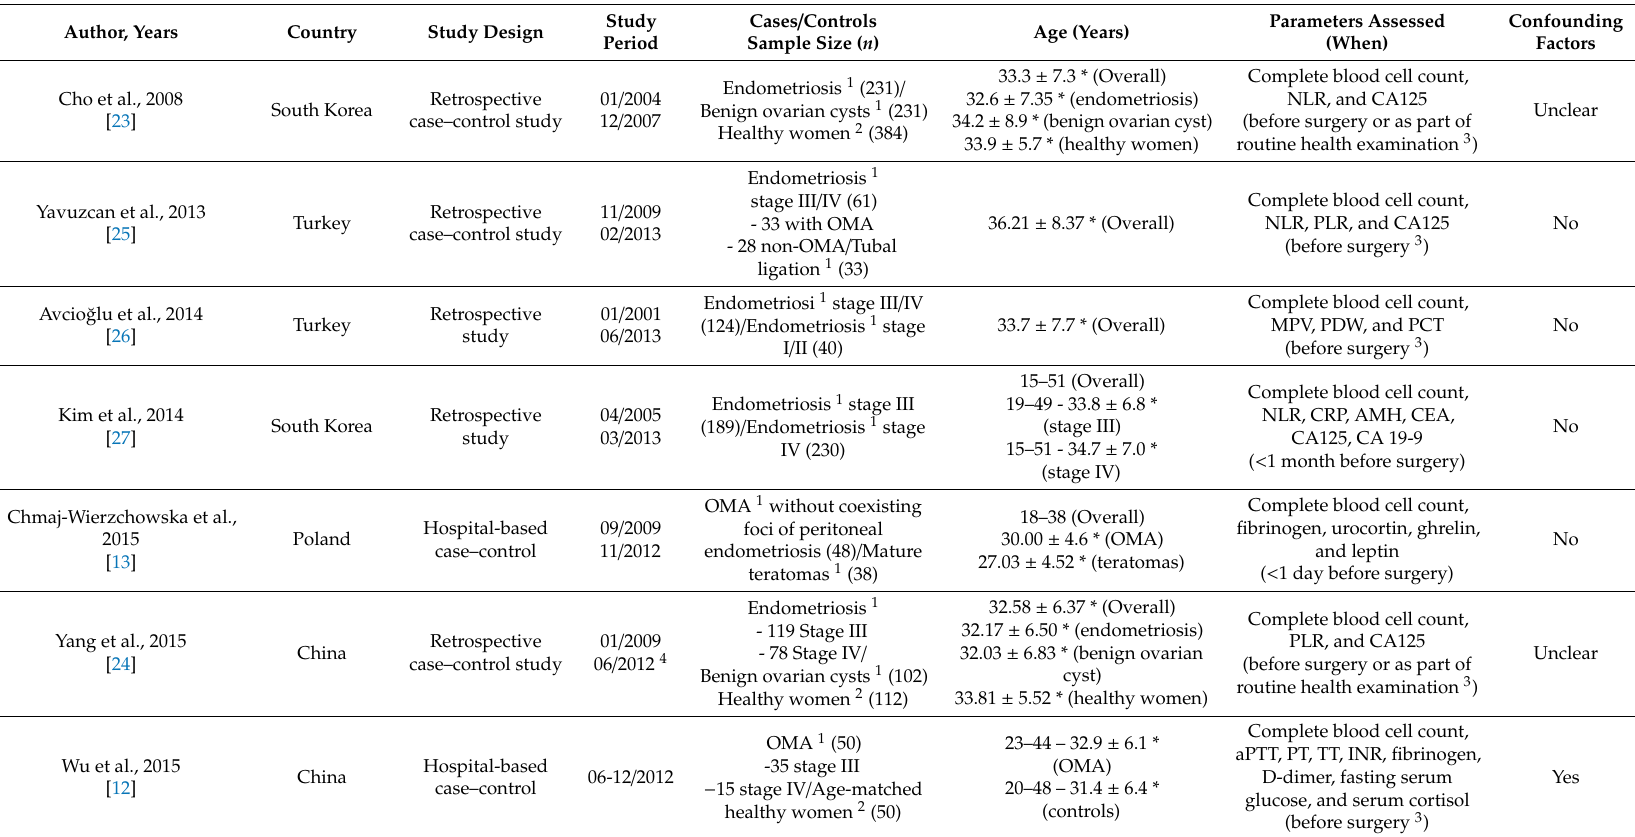
Table 5. Main characteristics of considered